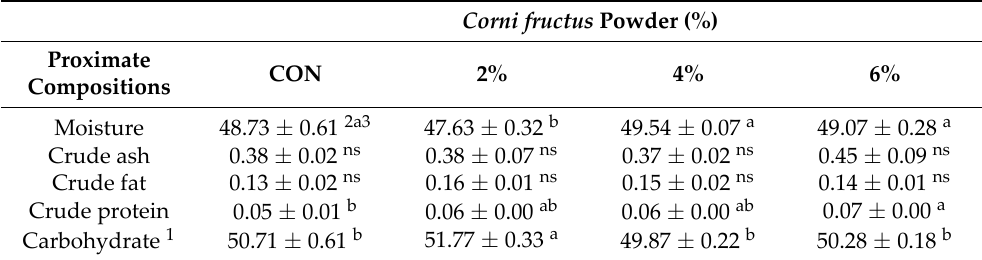
Table 2. Proximate compositions of Yanggaeng treated with Corni fructus